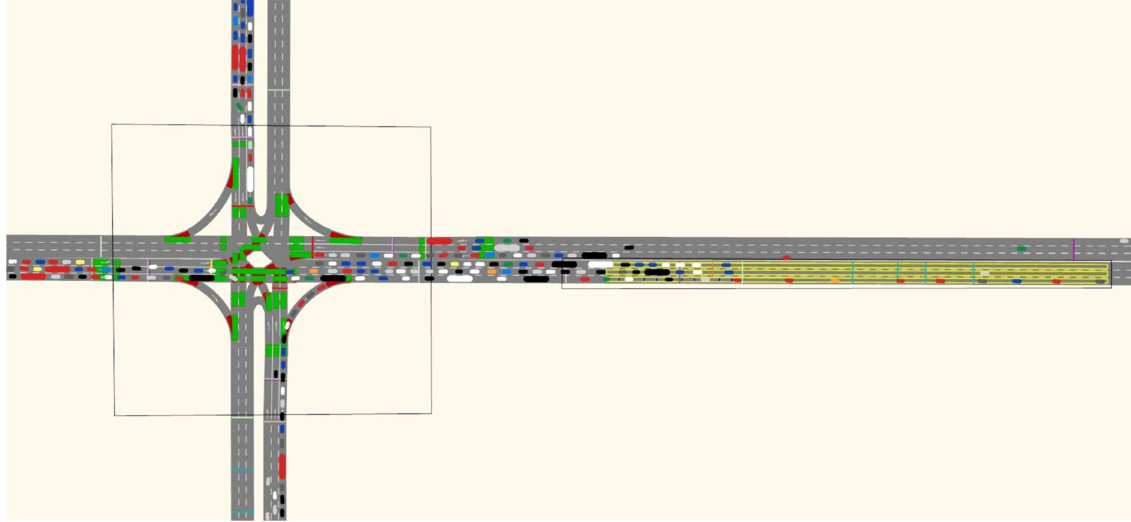
Figure 4. Simulation traffic